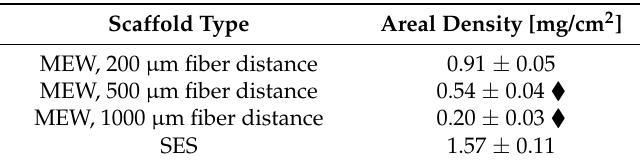
Table 1. Areal density of scaffolds from PCL fabricated by MEW and SES with different porous structure. Except for the (cid:7) marked scaffolds, each scaffold exhibited significantly different areal densities with p < 0.001 to each